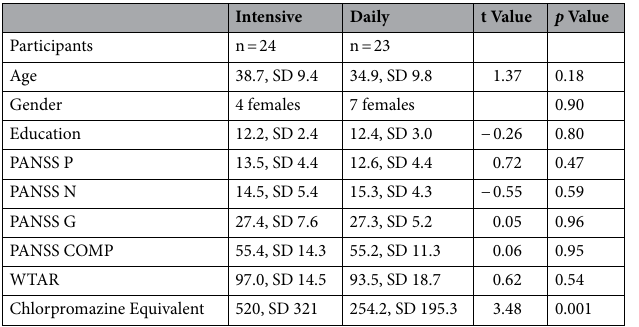
Table 1. Clinical and socio-demographic information of participants. SD standard deviation, education-in years, PANSS Positive and Negative Syndrome Scale ( P positive, N negative, G general, C composite), WTAR Wechsler test of adult reading.